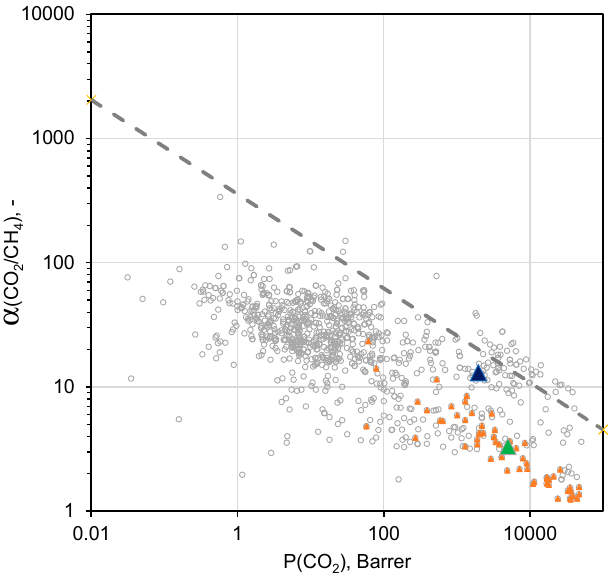
Figure 11. Robeson diagram for CO 2 / CH 4 mixtures.